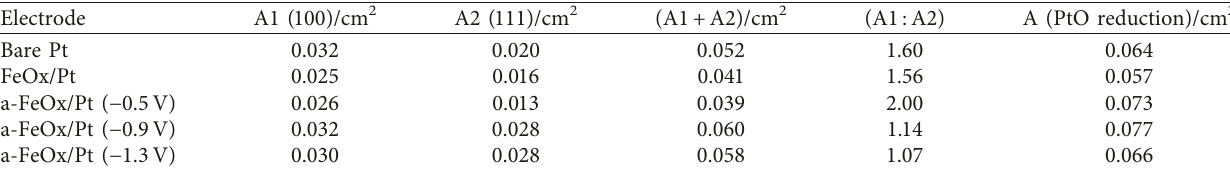
Table 1: The real Pt surface areas calculated based on the (H on the PtO ⟶ Pt reduction peak (A) utilizing a reference value of 420 µ C · cm − 2